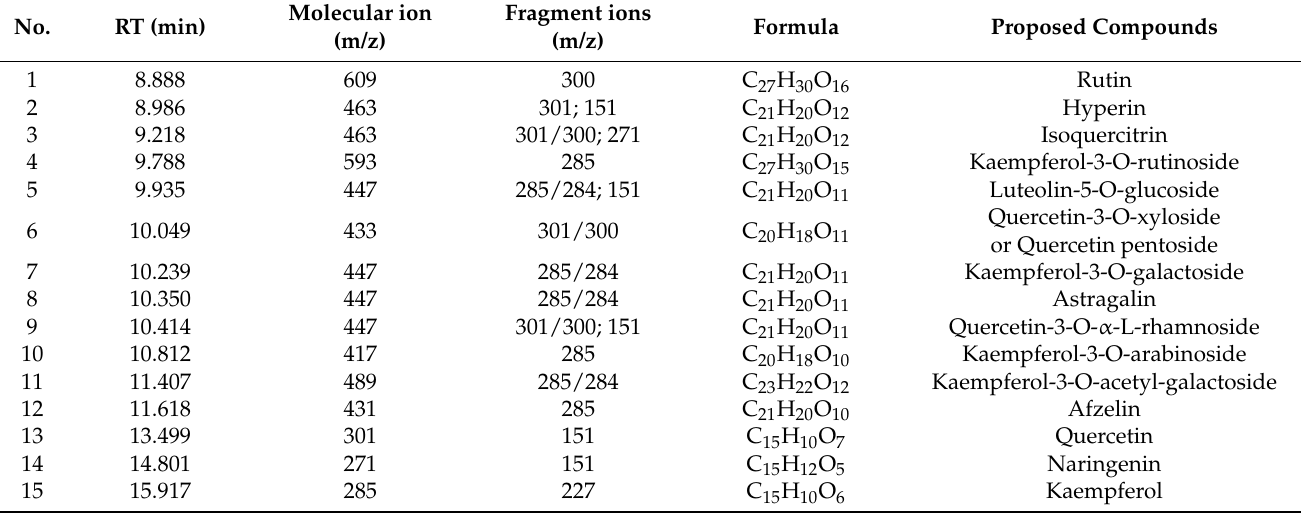
Table 2. Negative-ion ESI mass spectra of the main constituents of the TFC.